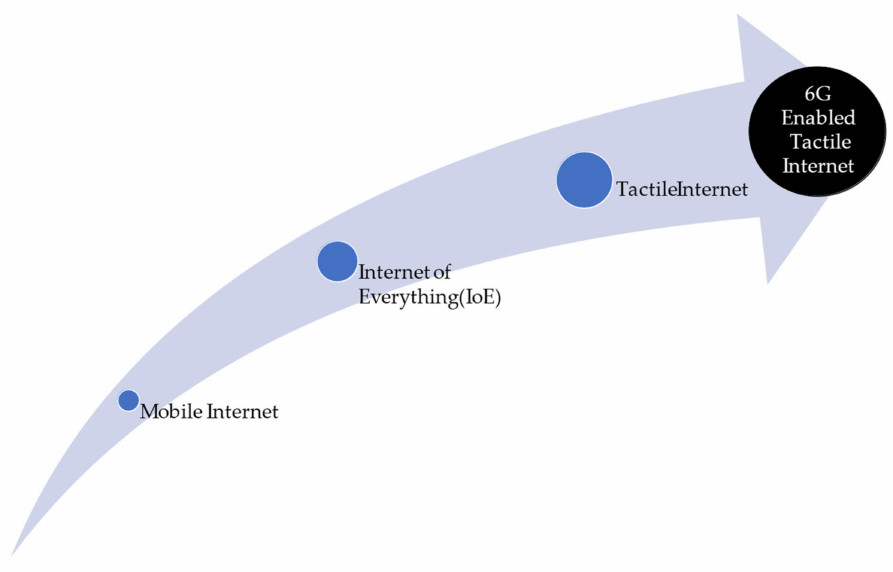
Figure 8. Leap evolution of 6G enabled Tactile Internet.